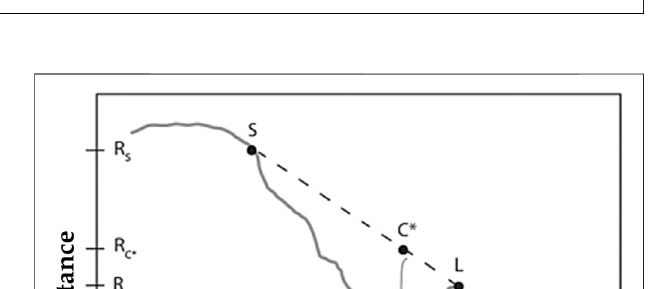
FIGURE 4 | Flow chart of data and methodology used in the study.